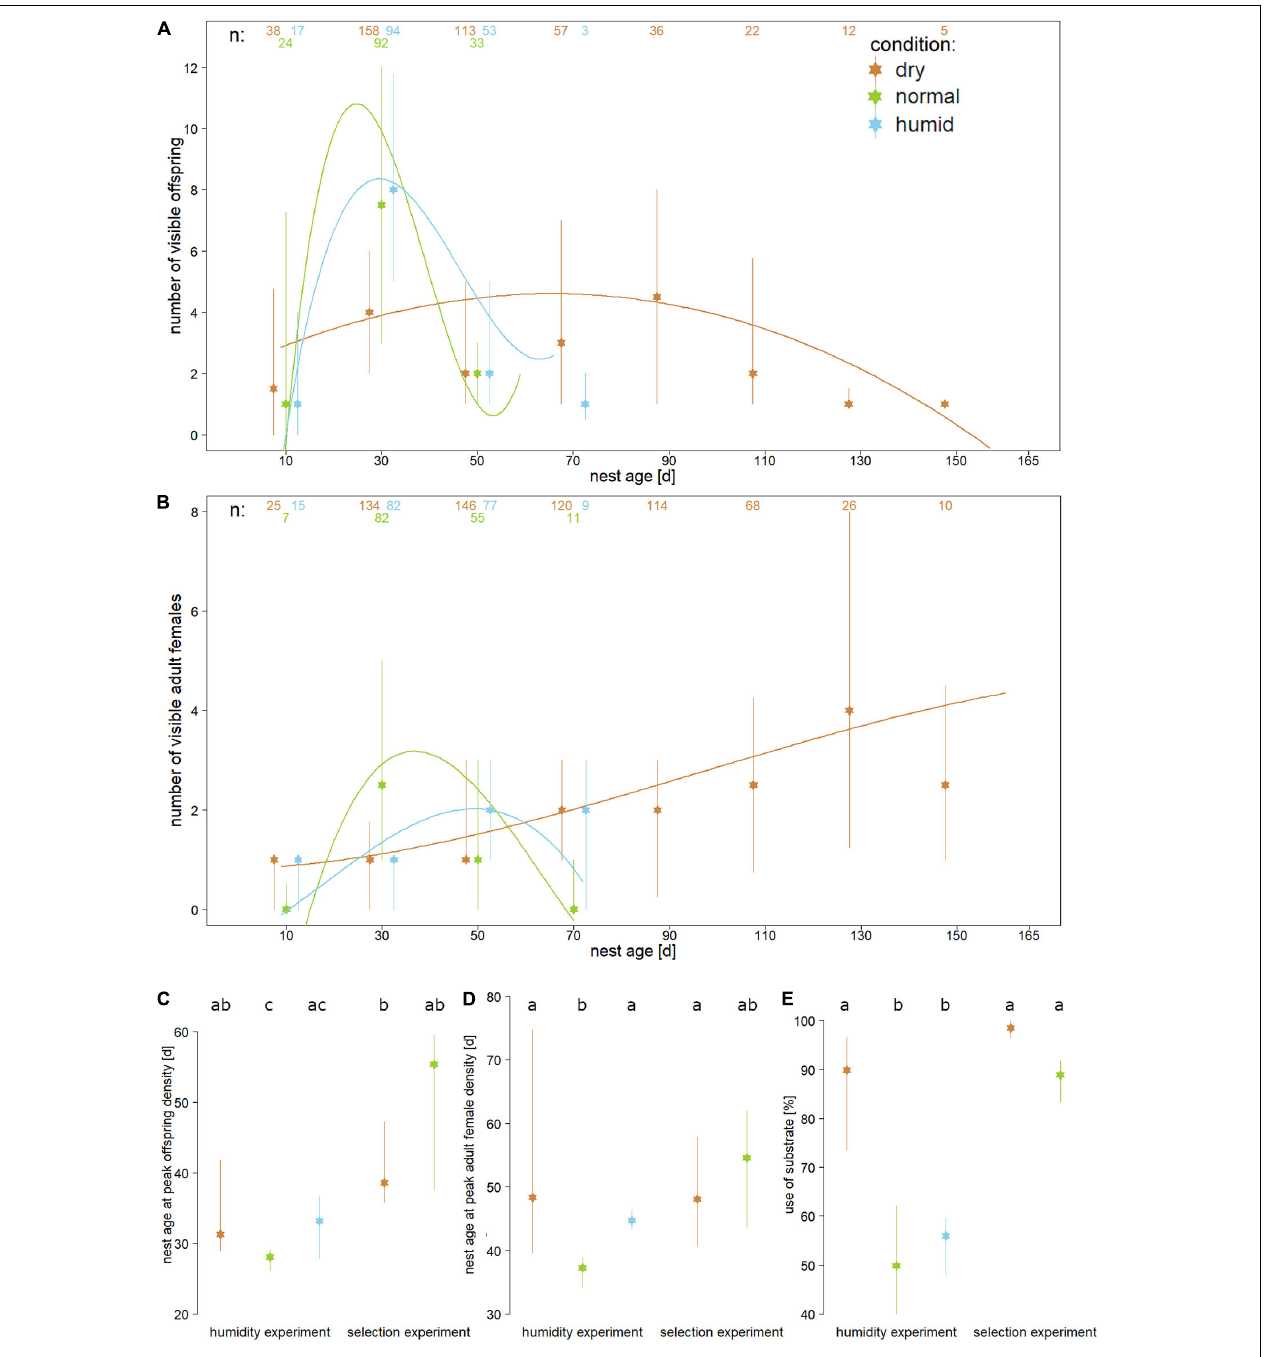
FIGURE 1 | Medians and interquartile ranges of relevant nest development parameters are displayed for three substrate humidities (“dry” = brown, “normal” = green, and “humid” = blue) measured during either the humidity experiment (A–E) or during the selection experiment (C–E) . The humidity experiment tested the influence of different substrates on first generation nests, whereas the selection experiment tested whether the beetles develop differently in “normal” or “dry” substrate after they were reared over five generations in “dry” substrate. Panel (A ) shows sub-adult (pupae and larvae) and panel (B) shows adult female peak densities for 20 day intervals. Numbers on top indicate the number of cumulative observations that were made for each treatment during each interval. Curves indicate regressions modelled as y = f(ax+bxˆ2+cxˆ3+d) for all data of each treatment, to illustrate the overall development of individual density across the treatments. For the statistical analysis we calculated the points in time of the highest individual density for every individual nest [shown in panels (C,D) ]. Panel (E) shows how deep the beetles dug into the substrate in both experiments. Different lower-case letters in the top line of panels (C–E) indicate statistically significant differences within each panel ( t - tests, corrected for multiple testing; P <